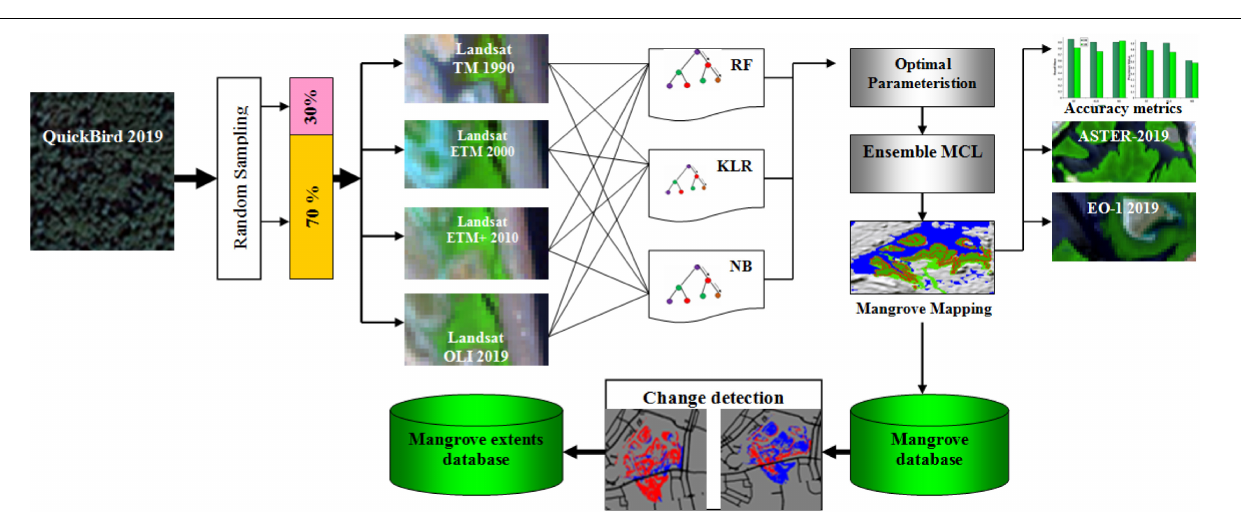
FIGURE 4 | Flowchart of the methodology applied in this